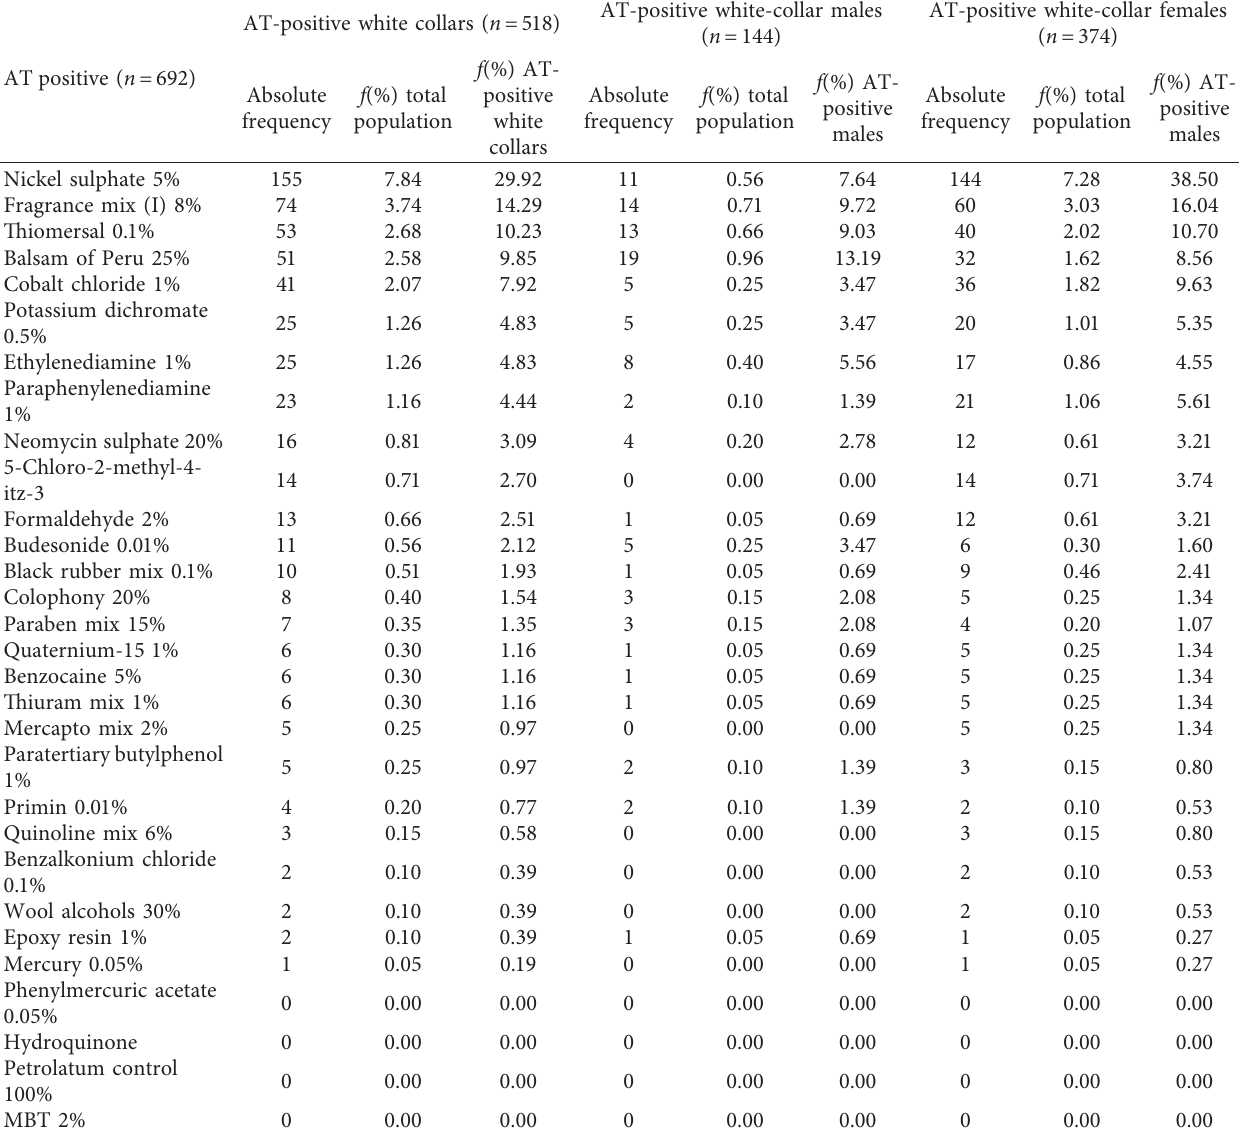
Table 7: Frequencies of the most prevalent allergens in the population with atopic dermatitis (AT), with respect to the white-collar (WhC) population, as well as the male and female WhC